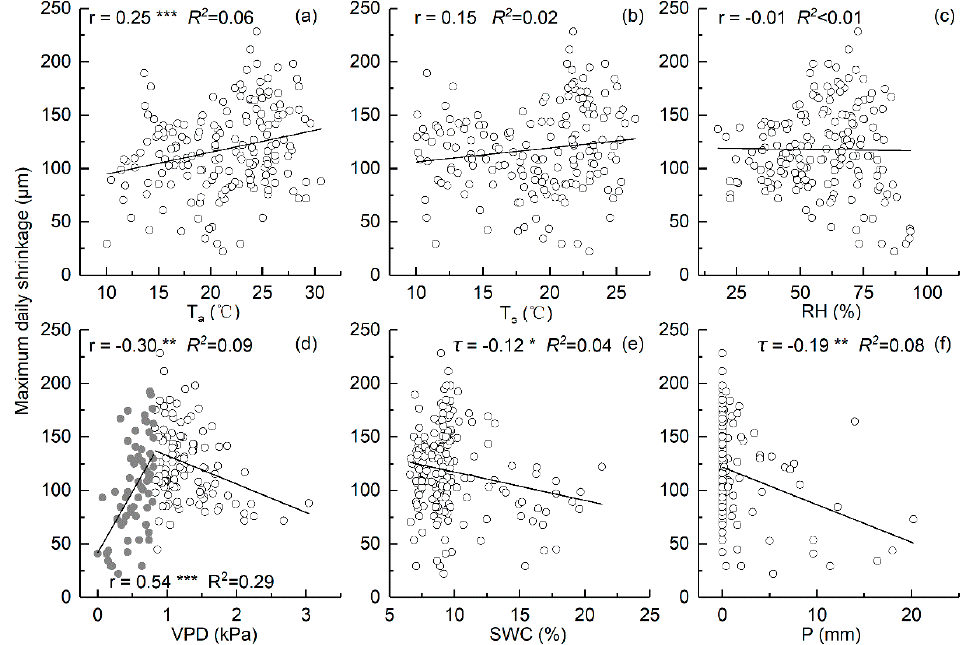
Figure 6. Correlations between MDS of P. orientalis and environmental factors of T a ( a ), T s ( b ), RH ( c ), VPD ( d ), SWC ( e ), and P ( f ) during growing season. Pearson correlation coefficient (r) values and Kendall’s tau coefficient ( τ ) values are shown with *: p < 0.05, **: p < 0.01, ***: p < 0.001. The gray and white dots in ( d ) indicate VPD values below and above 0.8 kPa, respectively.